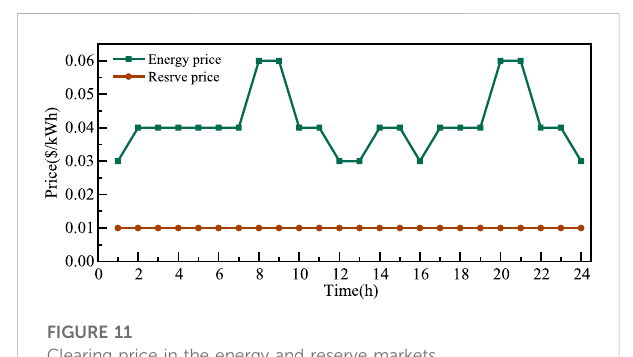
FIGURE 11 Clearing price in the energy and reserve